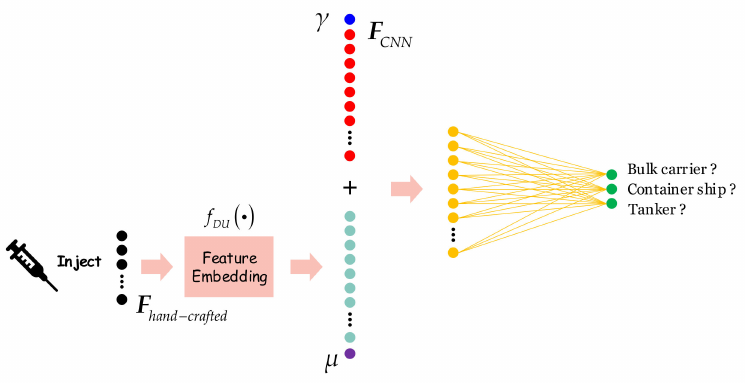
Figure 14. Diagrammatic sketch of the dimension unification weighted adding